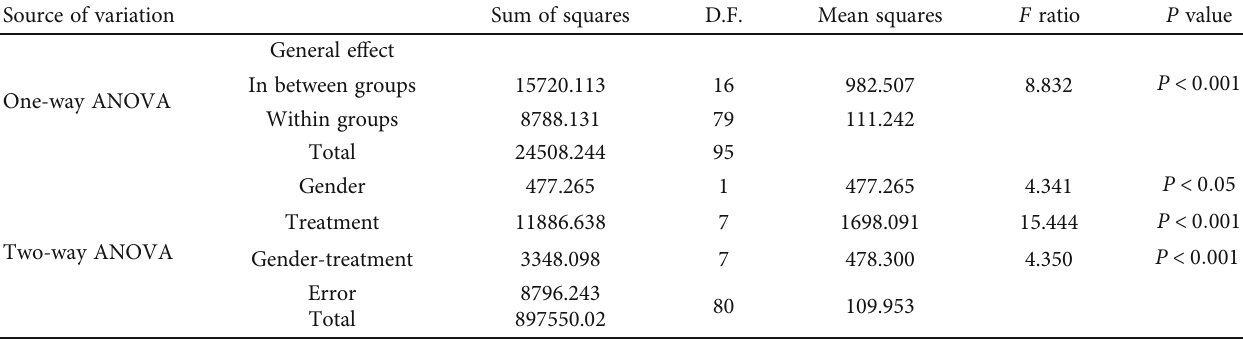
Table 5: One-way and two-way analysis for serum IL-10 (pg/mL) level in normal, arthritic and arthritic-treated rats. Source of variation Sum of squares D.F.